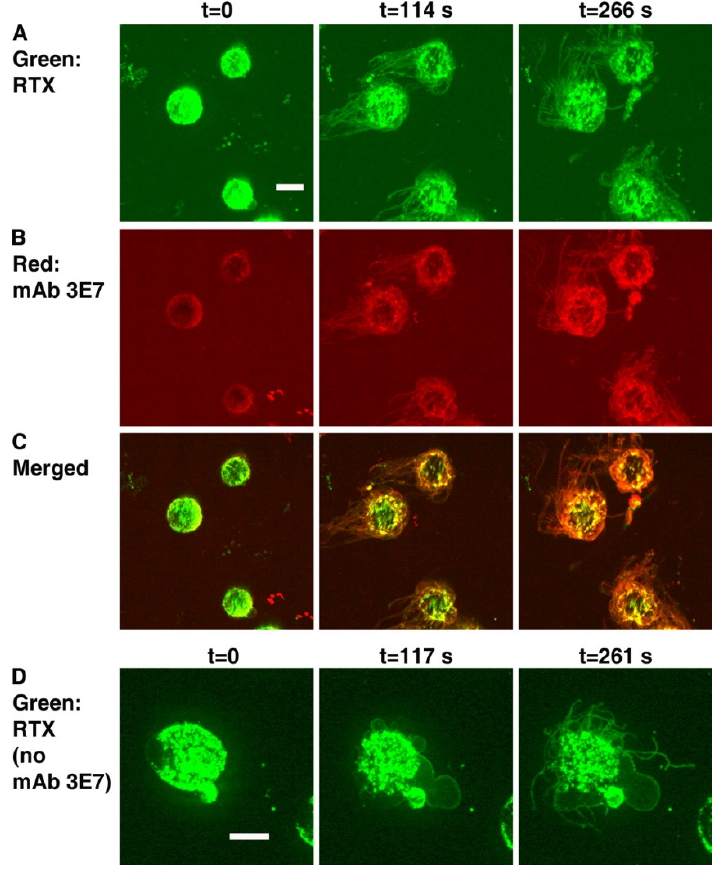
Figure 4. Binding of RTX to Daudi cells in NHS induces blebbing and streaming. ( A – C ), Images obtained at three different times for Daudi cells reacted with Al488 RTX, Al647 mAb 3E7, and NHS. ( A ), The 488 nm images show green RTX. ( B ), The 647 nm images show red mAb 3E7. ( C ), Merged images. Note that overlap of red and green produces orange or yellow. ( D ), Blebbing and streamers are generated in the absence of mAb 3E7. Daudi cells were opsonized with Al488 RTX and then reacted with NHS. Images for 488 nm are displayed at three time points. Green streamers can be seen to the left of the cells in panel A. The calibration bar in this and the following figures denotes 5 microns. The magnification in ( A – C ) was ×40, but, in panel ( D ) and all other figures derived from spinning disc confocal microscopy experiments, magnification at ×63 was used. [19] .